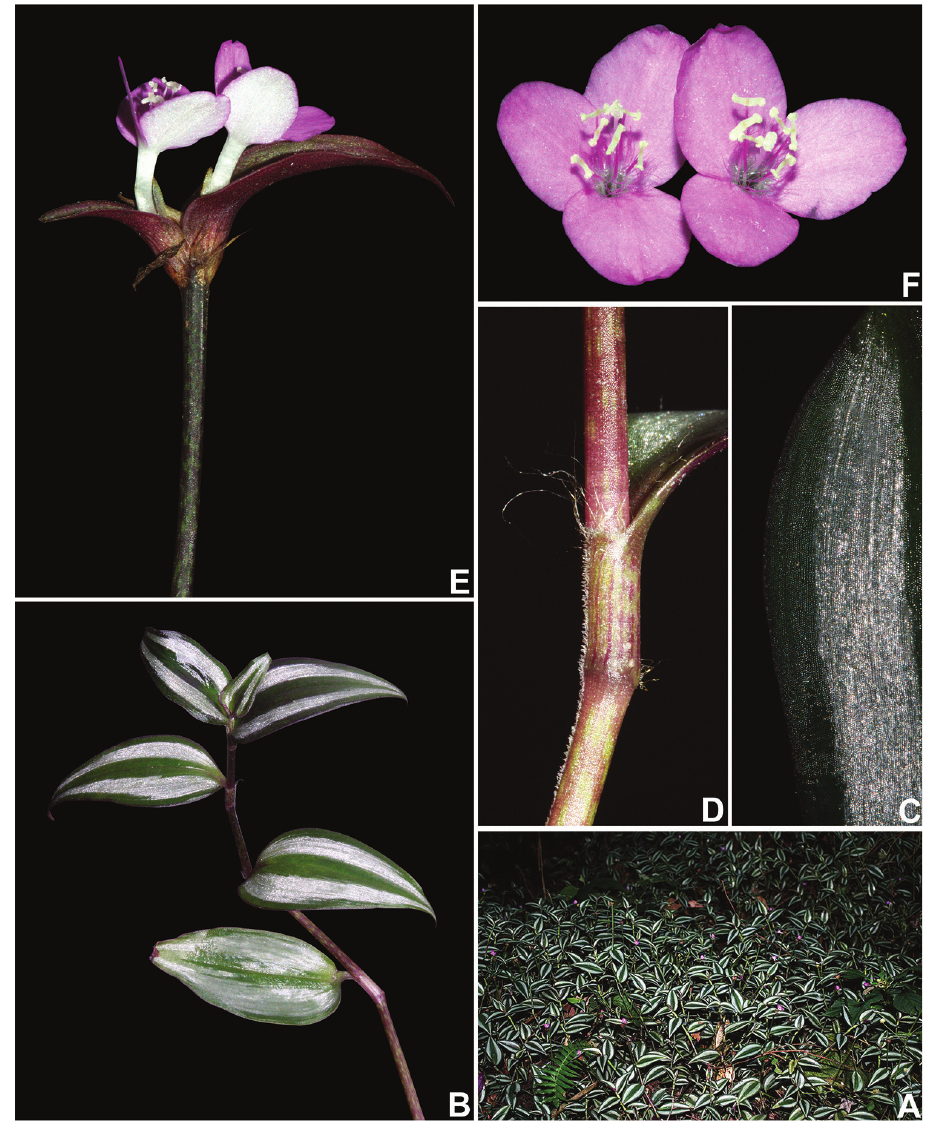
Figure 7. Tradescantia zebrina Heynh. ex Bosse. A habit B detail of a branch, showing the subpetiolate basal leaves, and blades with silver stripes C detail of the abaxial side of the leaf-blade D detail of the stem and leaf-sheath E detail of the terminal inflorescence, showing the spathaceous, saccate, unequal, conduplicate cincinni bracts, and long-tubular flowers with clawed petals F flowers. Photographs by M.O.O. Pellegrini.